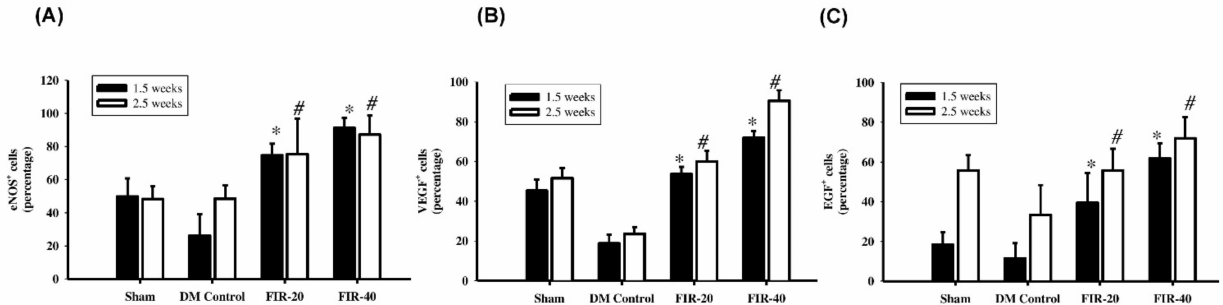
Figure 6. Far-infrared radiation (FIR) treatment in facilitating angiogenesis. The angiogenesis effect detected by eNOS ( A ), VEGF ( B ), and EGF ( C ) expression in the peri-wound tissue was investigated by using IHC staining. Expression of eNOS, VEGF, and EGF levels were increased, particularly in fibroblasts and endothelial cells, in the FIR-20- and FIR-40-treated diabetic groups at the early (day 10) and the late (day 17) stage post-treatment compared to the diabetic control group. In addition, eNOS, VEGF, and EGF expression were significantly increased in the FIR-40 group at the early and the late stage after treatment compared with the FIR-20 group. * p < 0.05 (at 1.5 weeks); # p < 0.05 (at 2.5